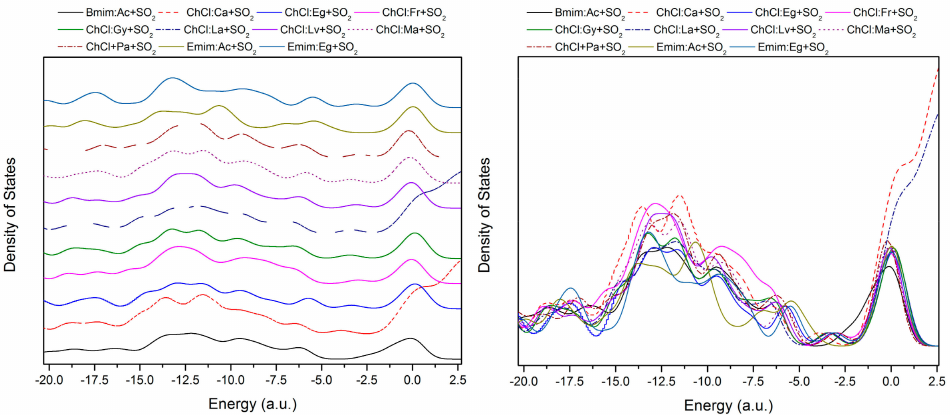
Figure 5. Density of states (DOS) as a function of orbital energy, E, for studied DES + SO 2 structures calculated at B3LYP / 6-311 ++ g(d,p) level. ( left —combined DOS plot for all DES + SO 2 systems; right —stacked with constant y-o ff set value on the DOS plot to separate the